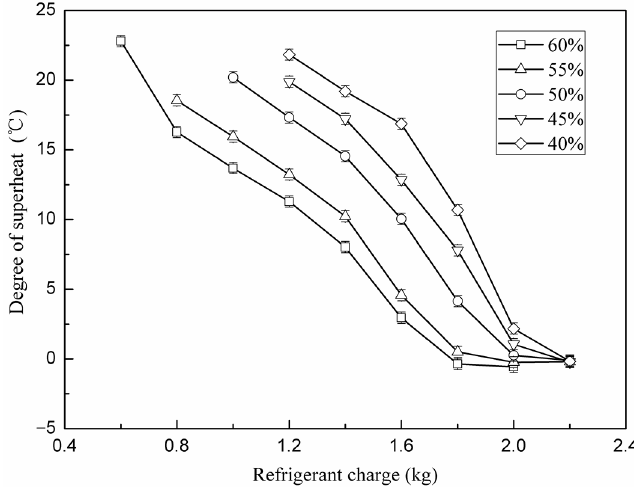
Figure 6. Variations of degree of superheat with refrigerant charge and EEV opening.